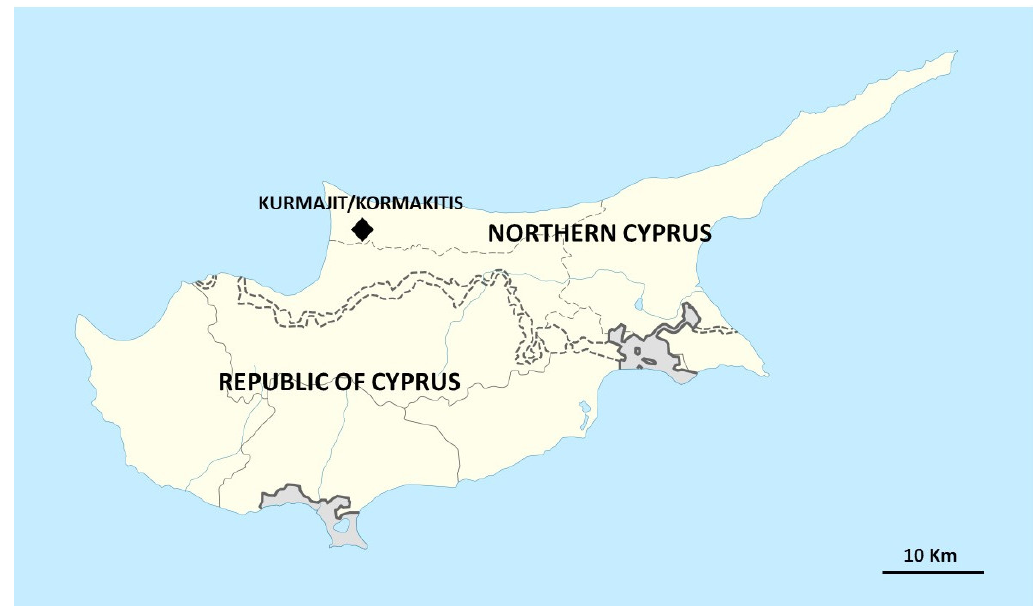
Figure 1. Location of Kormakitis in Cyprus.